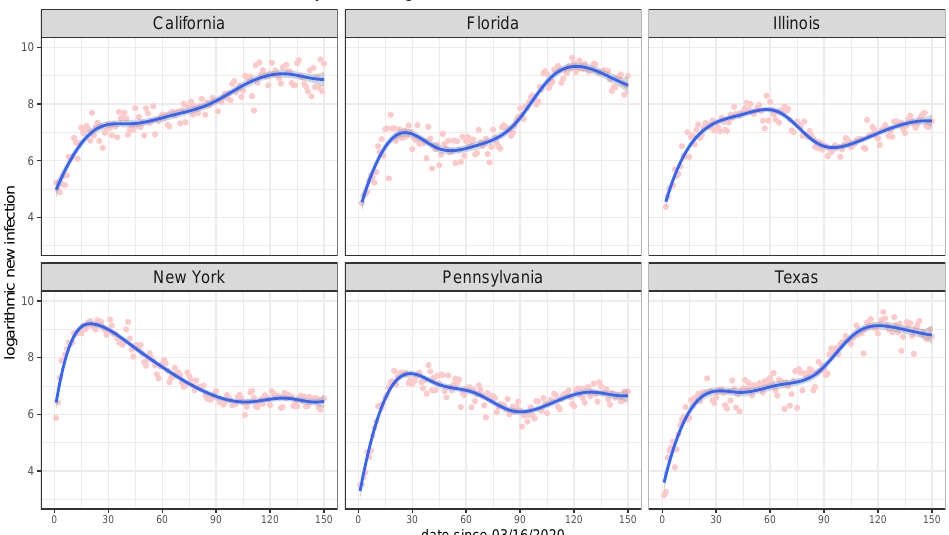
Figure 1. Illustration of the COVID-19 data. The X-axis records the dates from 16 March 2020 to 14 August 2020 and the Y-axis shows the numbers of the logarithm of the daily